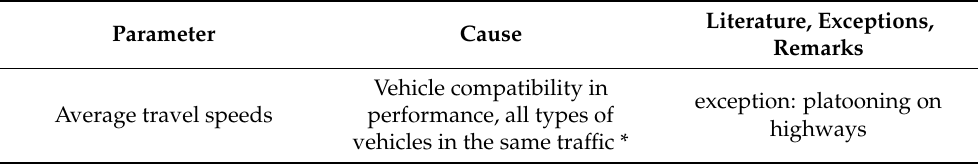
Table 8. Parameters which will not change drastically in the next